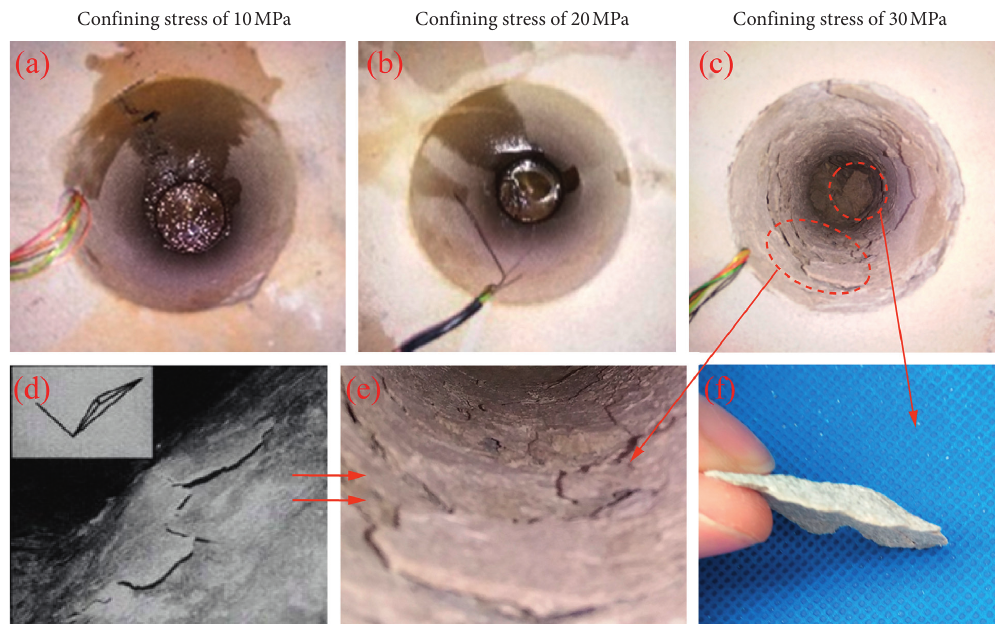
Figure 5: Photographs of the inner wall under initial confining stress of (a) 10, (b) 20, and (c) 30MPa. Comparison of failure fragments in the field and test, (d) the face of the tunnel [32], (e) and (f) failure fragments of